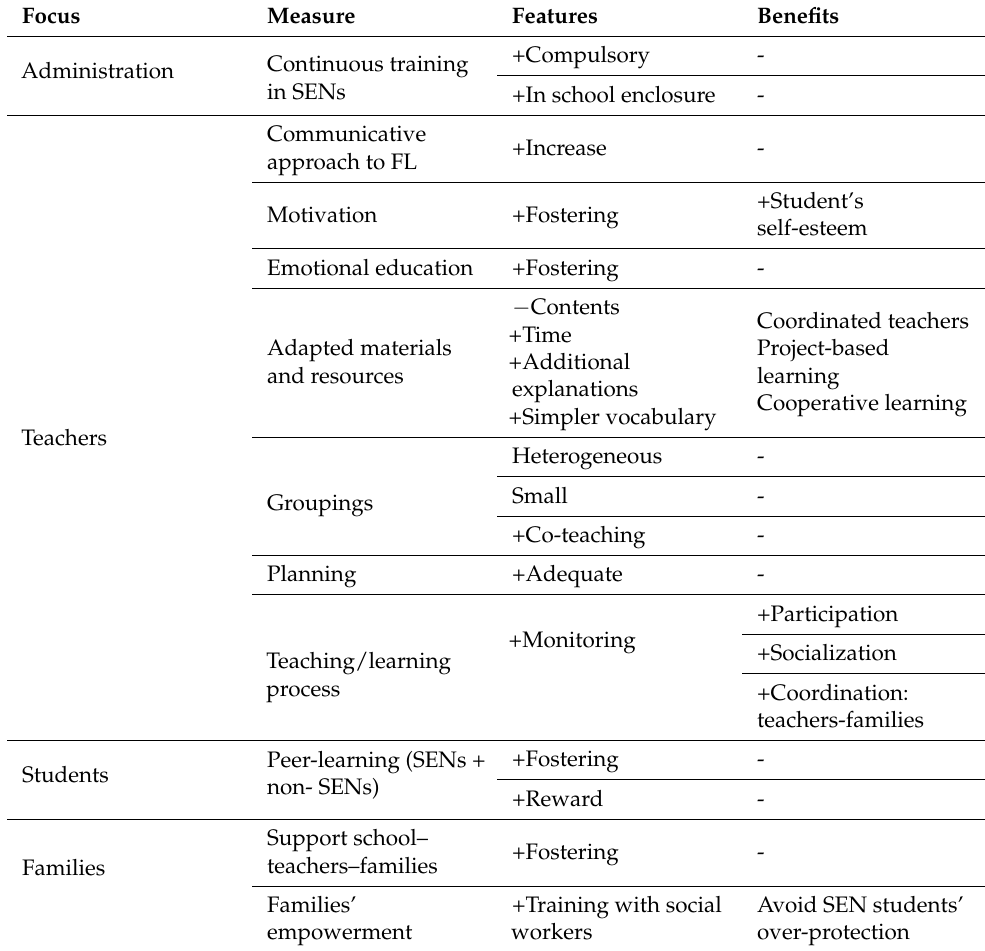
Table 5. Summary of stakeholders’ proposals to improve the teaching of an FL to the MID student.